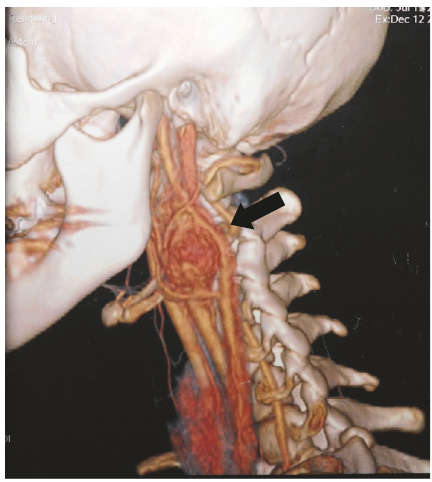
Figure 1: 3-dimensional (3D) cervical-computed tomography angiography (CTA), lyre sign (arrow).